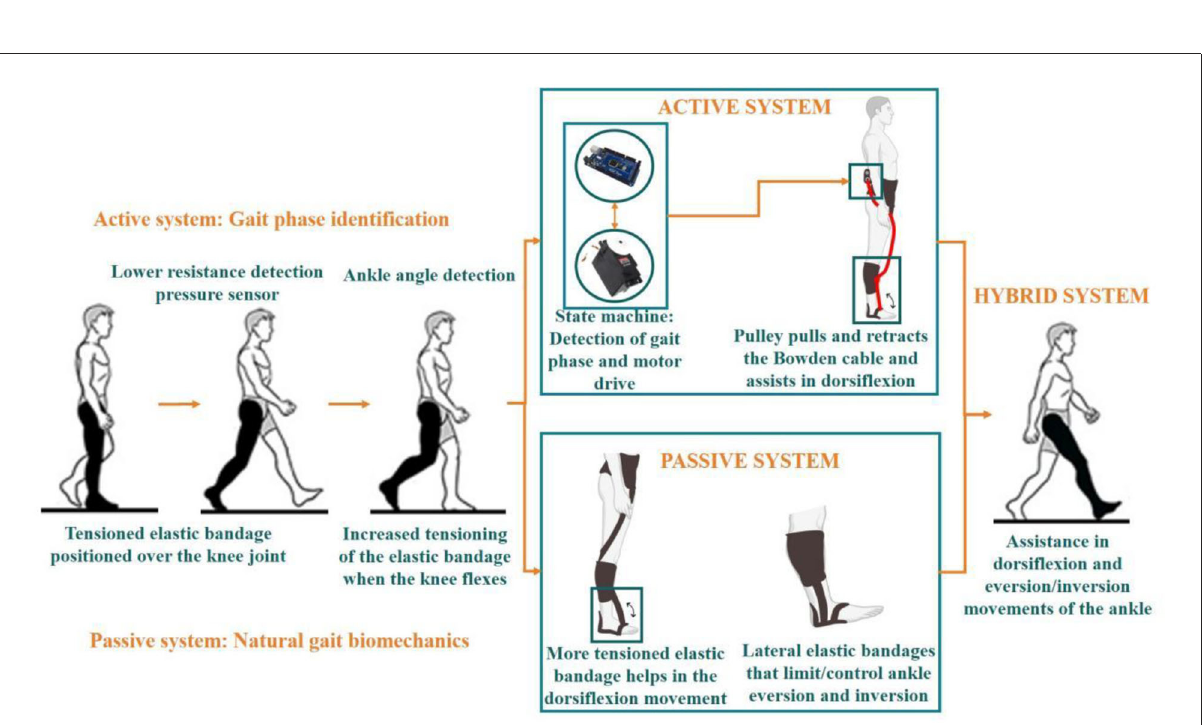
FIGURE4 G-Exos can be configured in three modes: active system, passive system, and hybrid (active + passive). The principle of operation is represented in the figure. Active system operation: has embedded hardware, composed of two FSR’s and an IMU, for the identification of the transition from the contact phase to the swing phase of the gait. With the integration of the sensor operation with the state machine method, the first condition of the firmware is to identify the decrease of resistance on the ankle, and then the condition of the ankle angulation range. When these conditions are met, the microcontroller triggers the servo motor which, when spinning together with a pulley, converts electrical energy into mechanical energy, pulling the Bowden cable and, consequently, helping to perform the ankle dorsiflexion. Passive system operation: Making use of the natural gait biomechanics itself, with tensioned elastic bands strategically positioned at the knee joint and one extremity at the tip of the foot, when the user flexes the knee, the elastic band is more tensioned and, consequently, assists in the execution of the dorsiflexion movement. Furthermore, with the lateral elastic bands positioned parallel to the ankle, their tension can be adjusted to control the amplitude of ankle eversion and inversion movement. Hybrid system operation: association of the active system with the passive system. Video link: